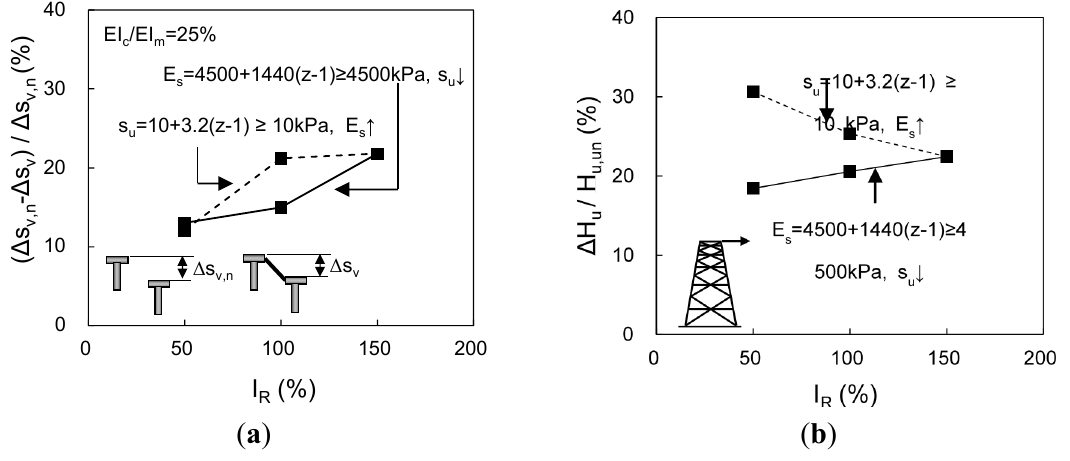
Figure 13. Effects of soil conditions on connected foundation: ( a ) reduction ratio of differential settlement and ( b ) increases in lateral load capacity of transmission